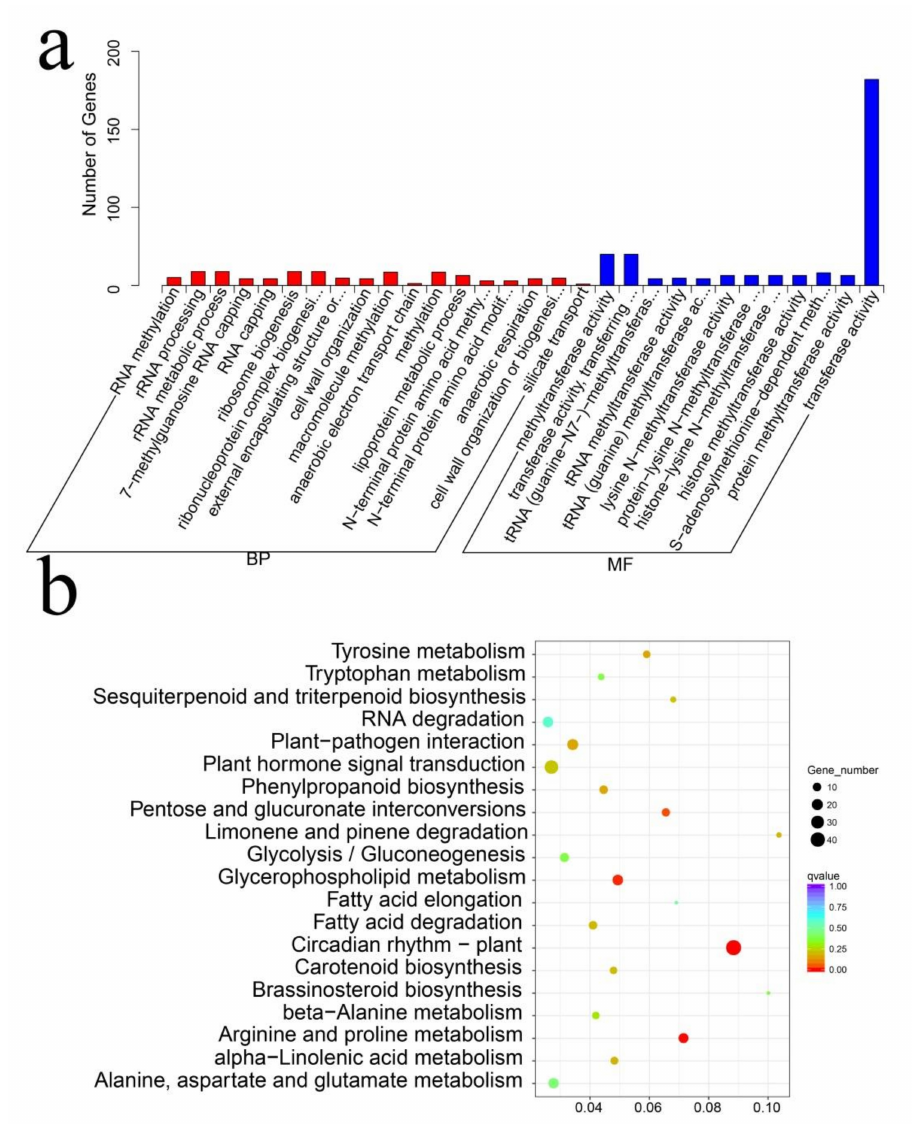
Figure 5. GO and KEGG analysis of DEGs from H. hamabo under salt stress. ( a ) GO analysis of DEGs from H. hamabo under salt stress. ( b ) KEGG analysis of DEGs from H. hamabo under salt